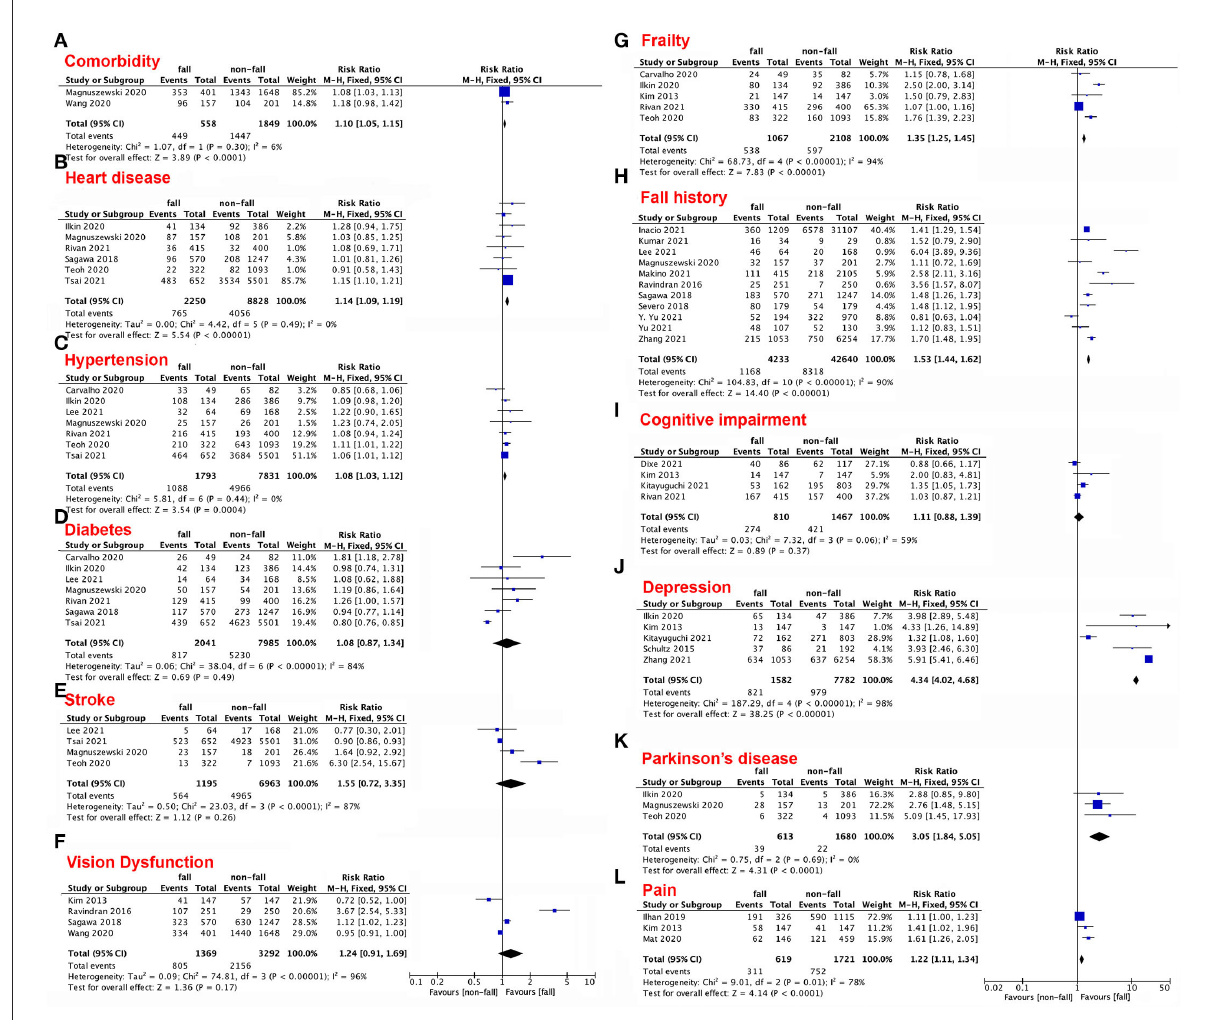
FIGURE3 (A–L) Forest plots of the impacts of comorbidities on the risk of